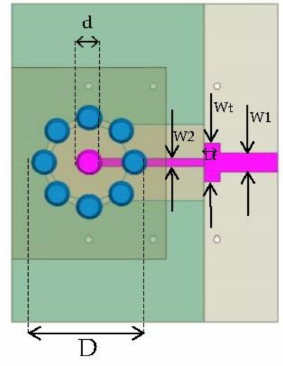
Figure 6. Vertical interconnection matching